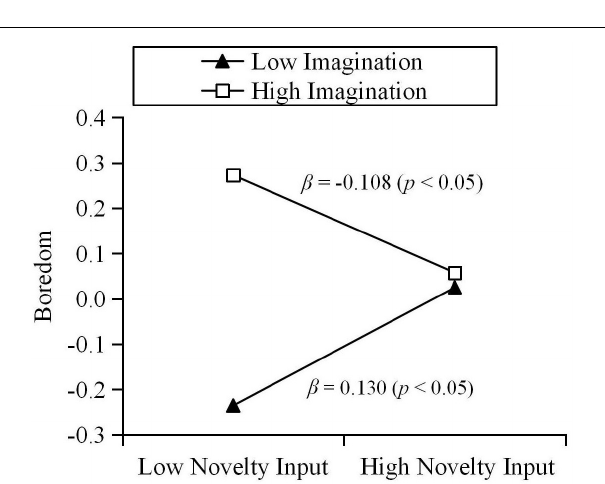
FIGURE 2 | Moderation effect of curiosity on the relationship between novelty input and boredom.